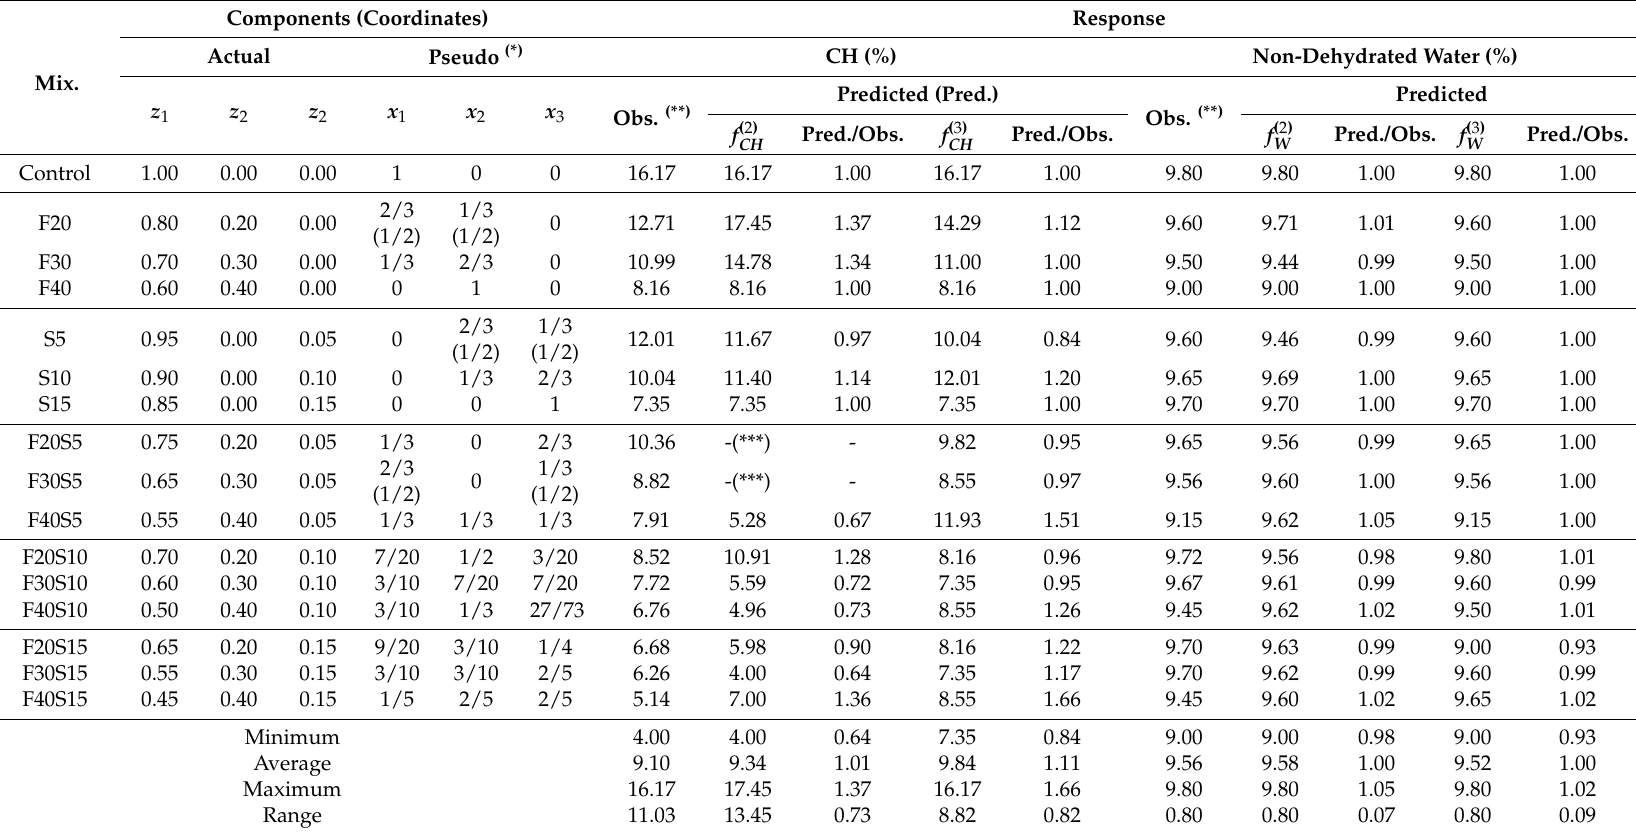
Table 4. Measured and predicted CH and non-dehydrated water contents of the developed